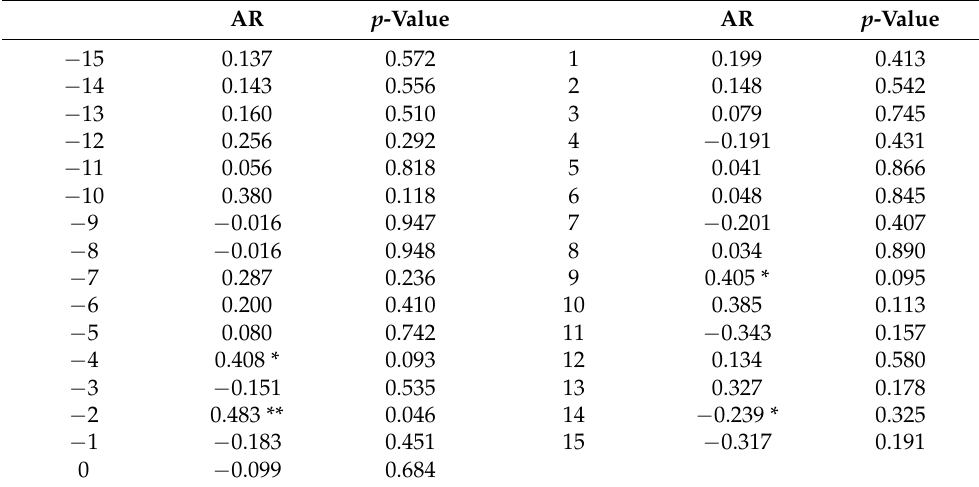
Table 1. AR of IC design houses in patent